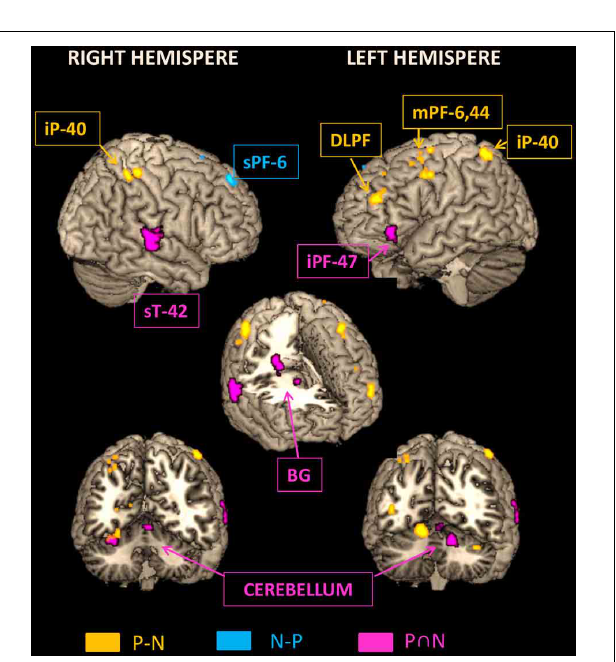
FIGURE 7 | Representation on rendered templates of the activated networks involved in the sequence formation (pink: N AND P conjunction), in the temporally Pause sequence (yellow: P > N), and in thetemporallyNo-Pausesequence(blue:N > P). Thecutouts(threelower images) display the activated structures in the depth of corticalgyri and in the sub-cortical structures, including basal ganglial. iP, Inferior parietal cortex; sT, Superior temporal cortex; Pc, Precentral cortex; sPF, Superior prefrontal cortex; DLPF, Dorso-lateral prefrontal cortex; iPF, Inferior prefrontal cortex; mPF, Middle prefrontal cortex; BG, Basal ganglia; Cb, Cerebellum.